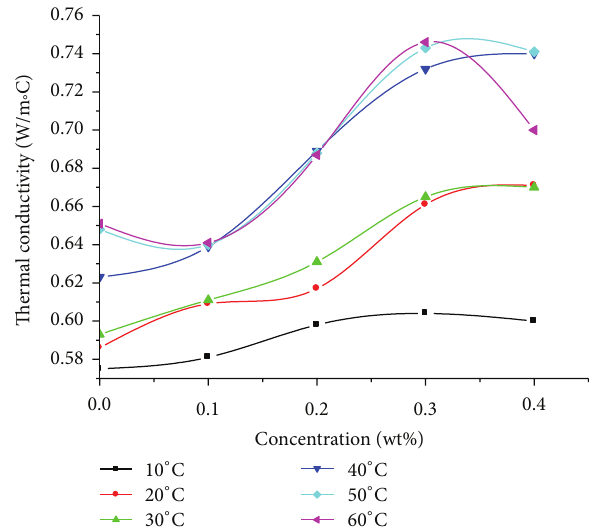
Figure 6: Weight concentration (wt%) versus thermal conductivity.